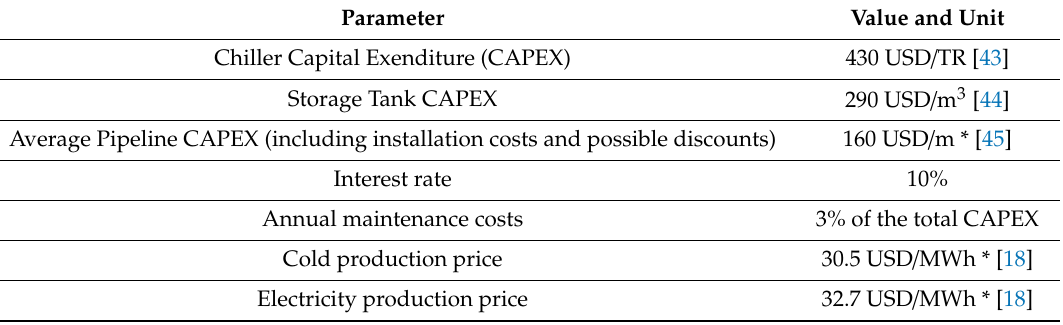
Table 1. Input parameters for the economic assessment